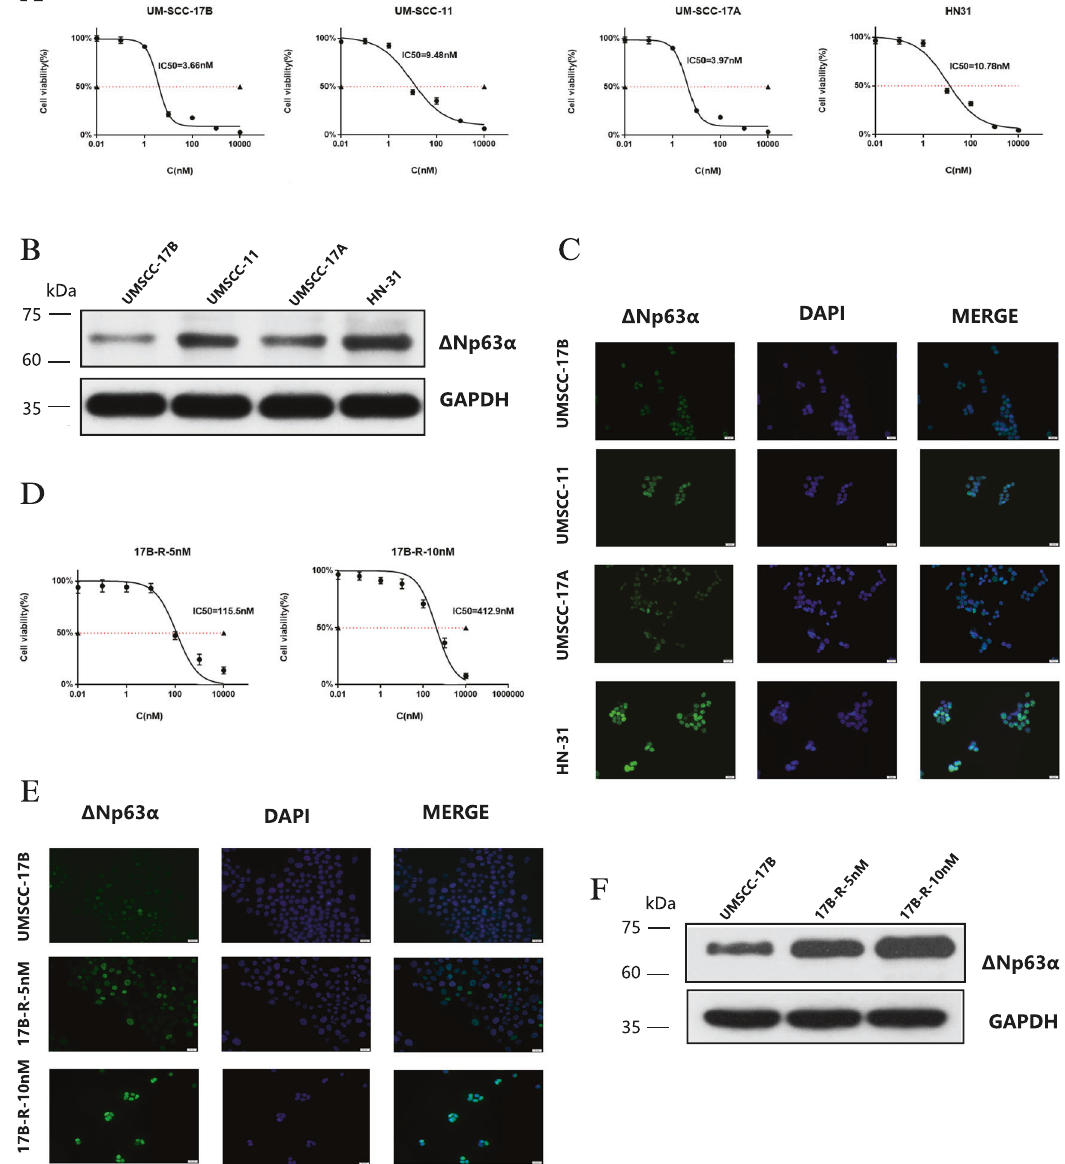
Fig. 1 The bortezomib sensitivity of HNSCC is associated with the expression level of Δ Np63 α . A UMSCC-17B, UMSCC-11, UMSCC-17A, and HN31 cells were treated with increasing concentrations of bortezomib (0.01 – 10000 nM) for 24 h, viable cells were quanti fi ed using the CCK-8 assay. Each data point represents the means ± SD of three separate experiments. B . Western blot was performed to analyze Δ Np63 α proteins levels of UMSCC-17B, UMSCC-11, UMSCC-17A, and HN31 cells. C . Four cells were observed for Δ Np63 α by immunostaining with antibody (green). Nuclei are counterstained with DAPI (blue). Scale bar: 20 μ m. D . After “ step-wise ” inducing drug-resistance cell culture, 17B- R-10nM drug-resistant cell line that can proliferate in culture medium containing 10 nM bortezomib was obtained. IC50 of 17B-R-5nM and 17B-R-10nM were calculated using, CCK-8 assay. E . UMSCC-17B, 17B-R-5nM, and 17B-R-10nM were observed for Δ Np63 α by immunostaining with antibody (green) Scale bar: 20 μ m. F . Altered expressions of Δ Np63 α were evaluated by western blot analysis in UMSCC-17B, 17B-R-5nM, and